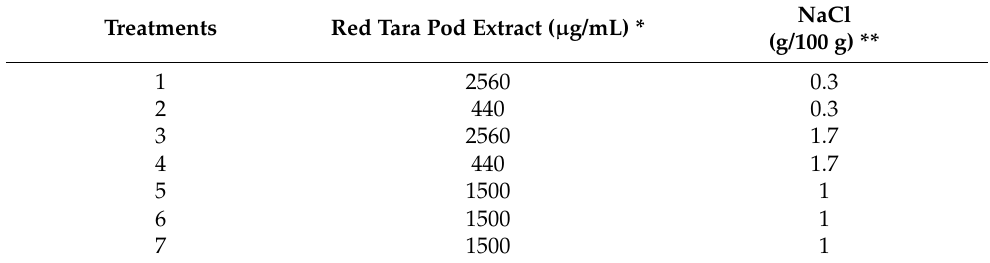
Table 2. Evaluated operational